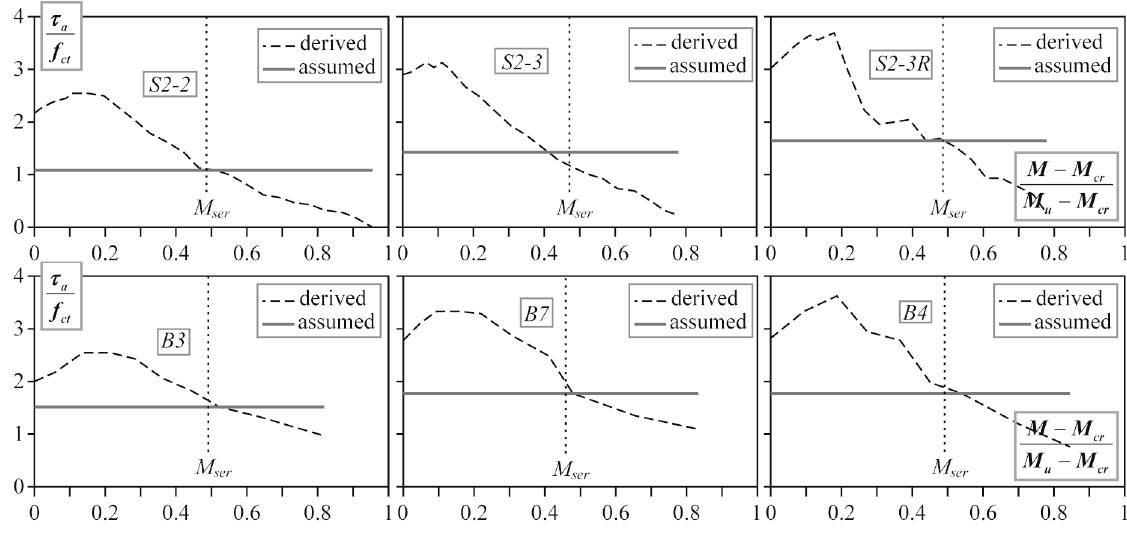
Fig. 7. Derived and assumed bond stresses